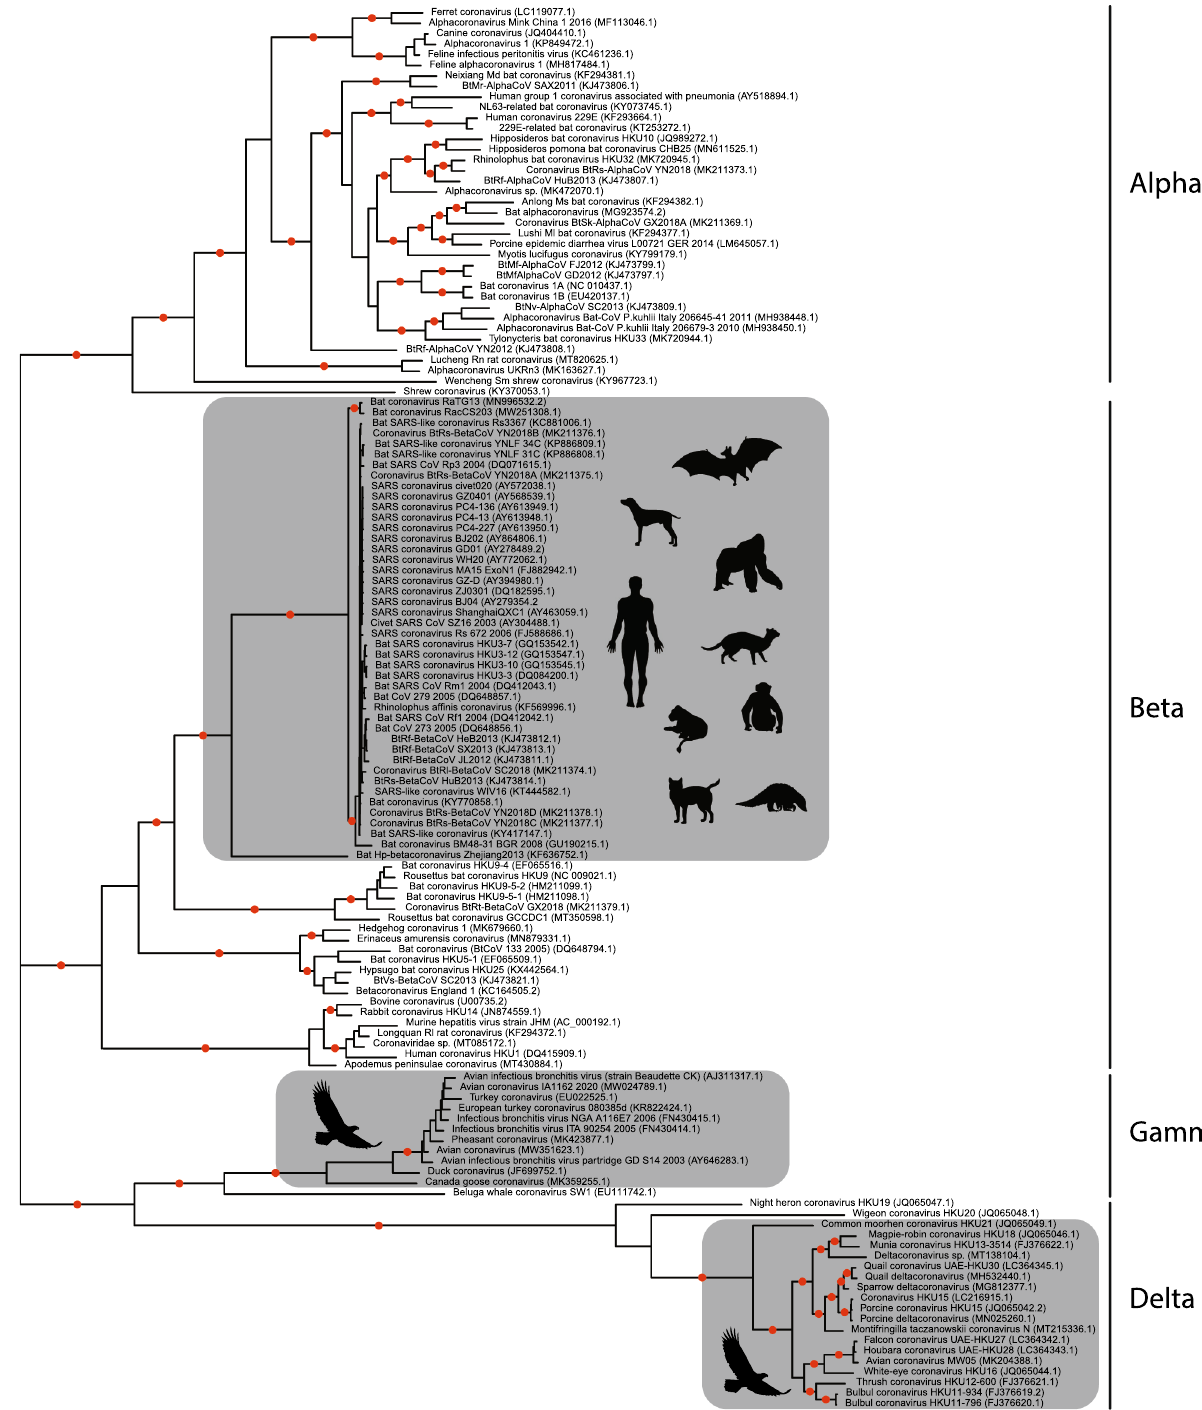
Figure 1. Unrooted maximum‑likelihood tree of mothur‑clusterized coronavirus ORF1ab sequences. Terminal edges represent single isolates or clusters of highly similar sequences represented by a random sequence within the cluster (see main text and Supplementary Table 1 for details). In addition to the data downloaded from GenBank, the analysis also included sequences from GISAID for strains isolated from lesser known hosts (i.e. cats, dogs, etc., see Supplementary Table 1 for details). Grey boxes represent s2m‑containing accessions and Coronaviridae genera names are shown. Red dots indicate branches with 100% bootstrap